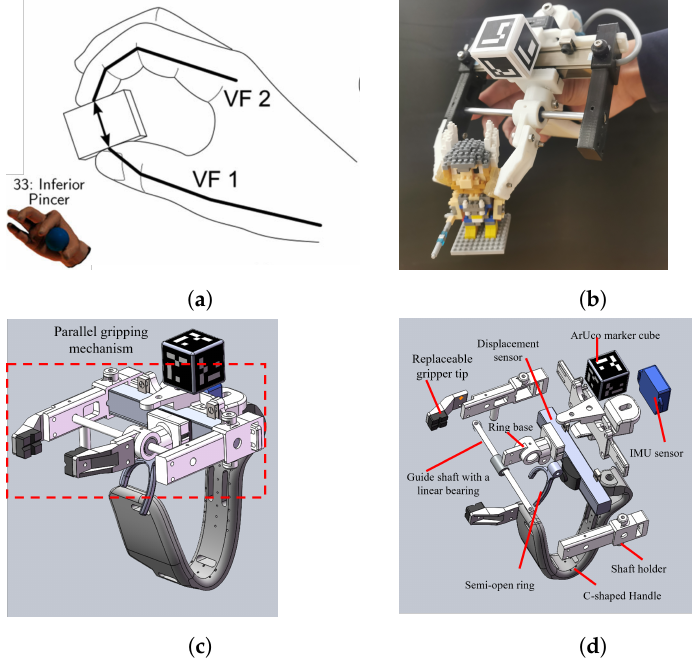
Figure 2. Grasping method and design of the exoskeleton. ( a ) Inferior pincer grasp (Adapted from [23]). ( b ) Usage of the exoskeleton. ( c ) Assembly view of the model. ( d ) Exploded view of the model.